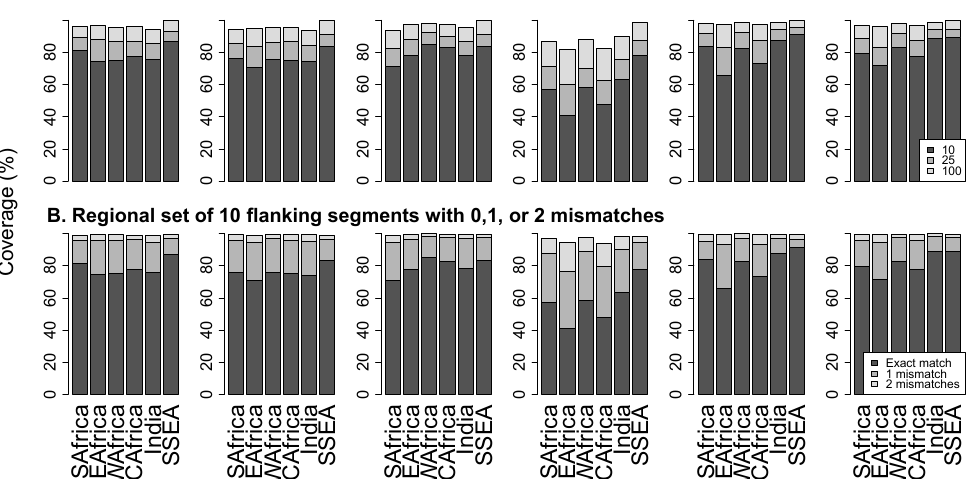
Figure 4. Panel ( A ) shows the proportion of sequences that exactly match the 10 (black bar), 25 (dark grey), and 100 (light grey) most common regional flanking segments. Panel ( B ) shows the proportion of sequences that exactly match (black bar), differ by one nucleotide (dark grey), or differ by two nucleotides (light grey) from the 10 most common regional flanking sequences. Abbreviations: SAfrica, Southern Africa; EAfrica, East Africa; WAfrica, West Africa; CAfrica, Central Africa; SSEA, South and Southeast Asia.